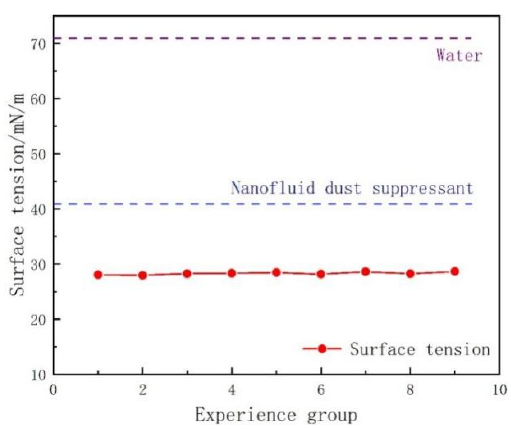
Figure 5. Surface tension value of dust suppressant.